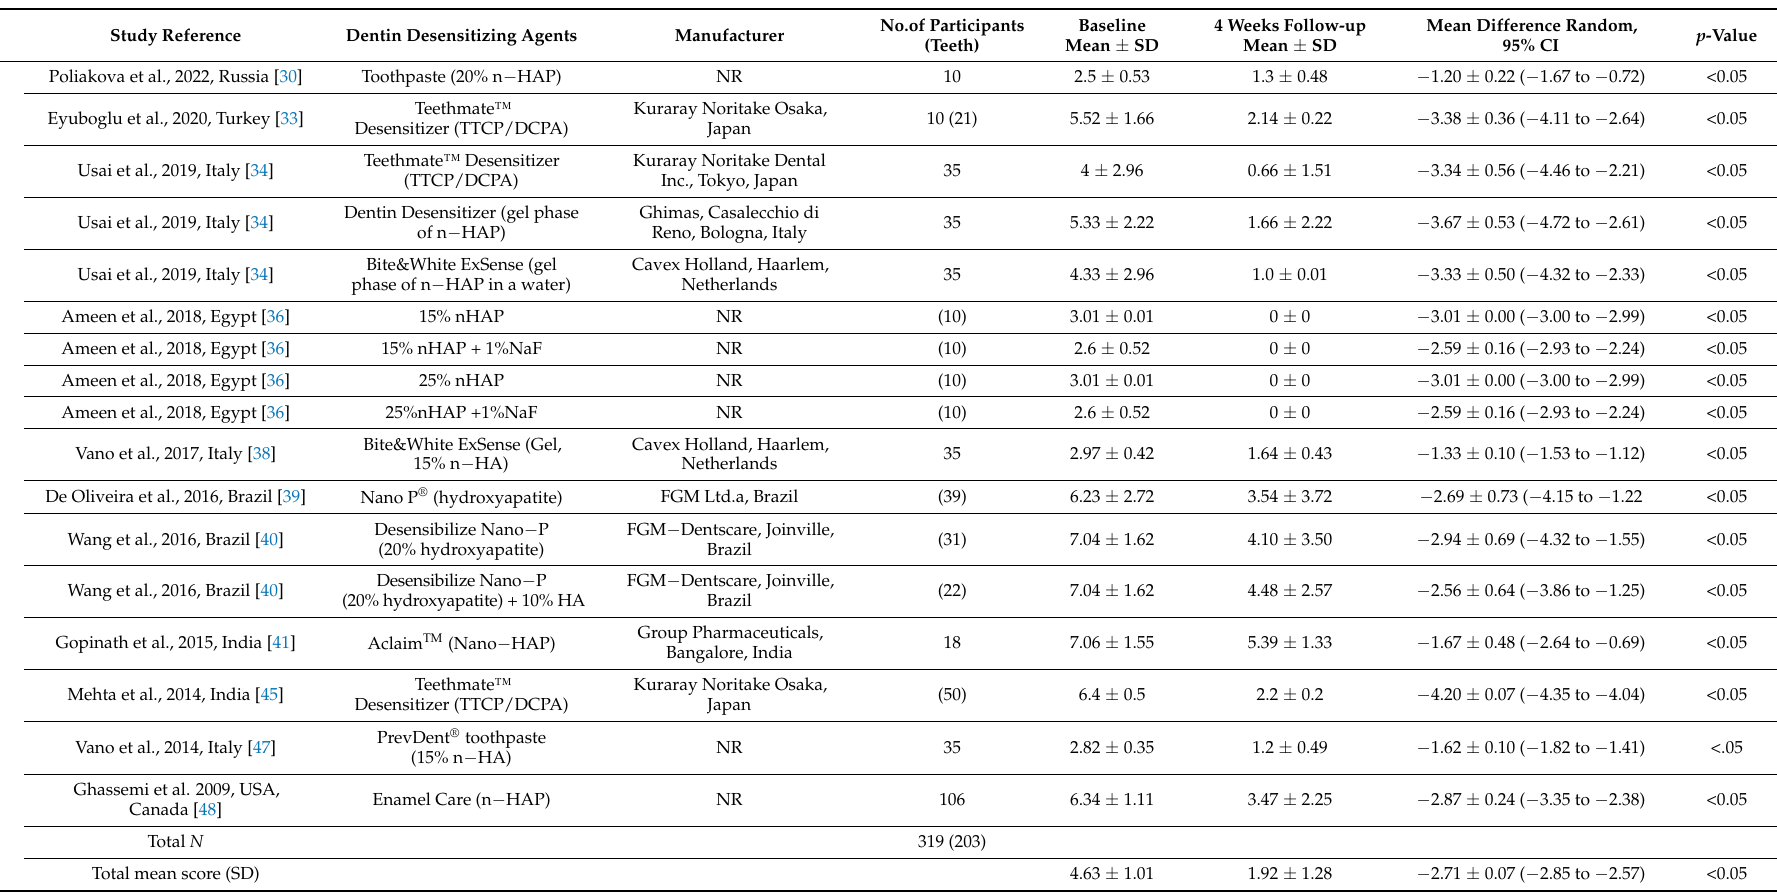
Table 3. Mean difference and standard deviations (SD) of visual analogic scale scores between 4 weeks follow-up and baseline after calcium phosphates application (subgroup analysis according to the test